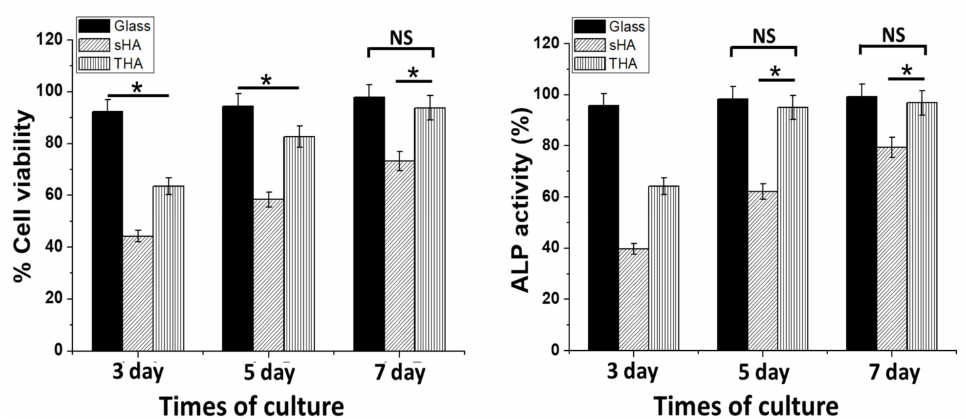
Figure 9. MTT assay and the relative alkaline phosphatase (ALP) activities of sHA and THA compared with the glass substrate (positive control; paired with each material) on days 3, 5, and 7. The control values were normalized to 100%. * p < 0.05 compared with the corresponding control group (mean ± SE). NS: no significance between the two